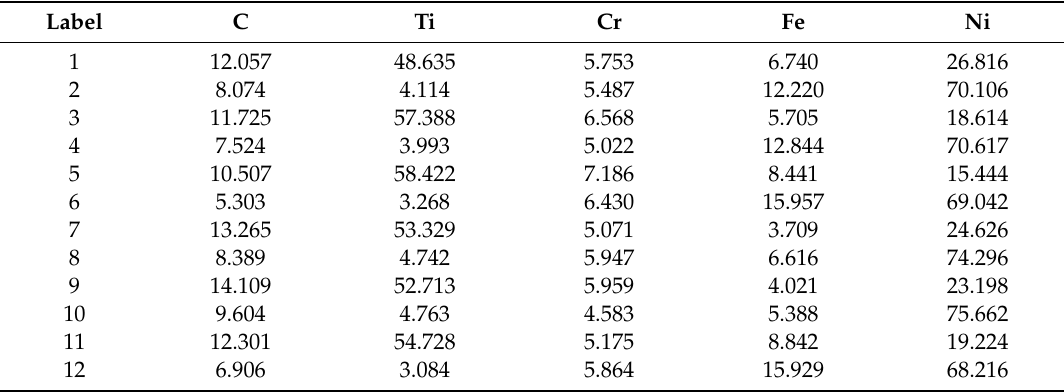
Table 8. Element content table of cladding structure determination at di ff erent scanning speeds. (Labels 1–6 belong to 6# sample, Labels 7–12 belong to 8# sample.)